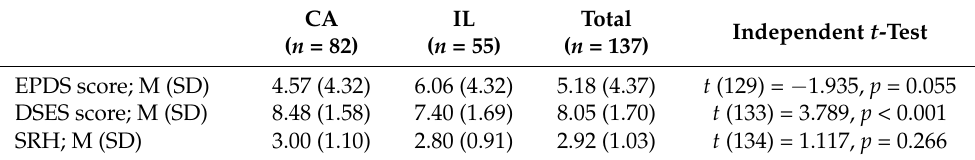
Table 2. Descriptive statistics for depressive symptoms, self-efficacy, and self-rated